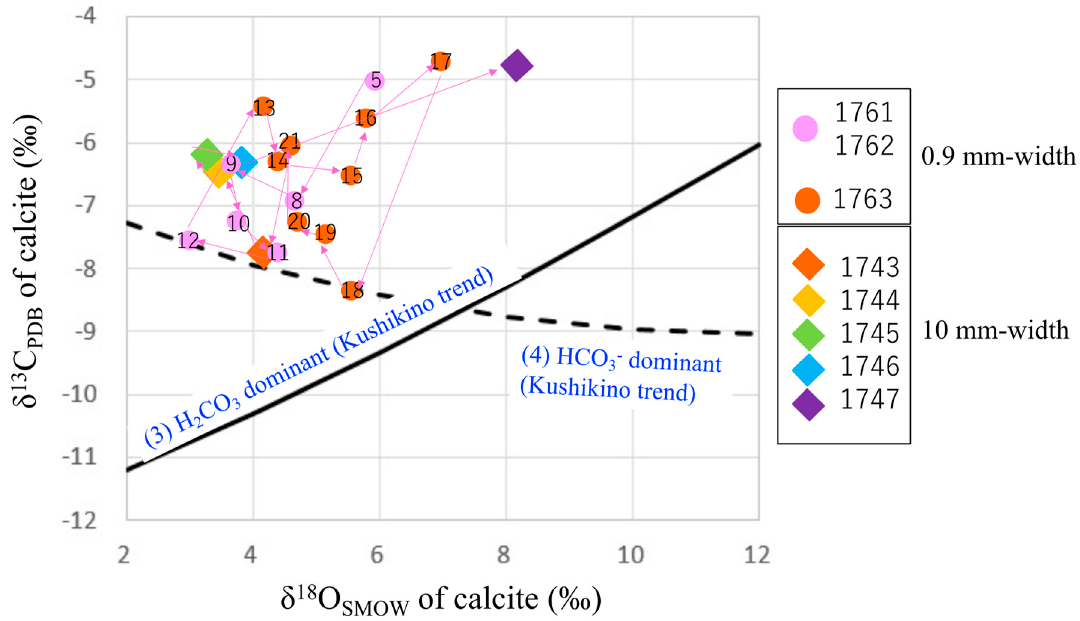
Figure 8. The δ 13 C and δ 18 O values of calcite (10 mm-width sample set and 0.9 mm-width sample set) from the 20100317 sample (Table 3). The number with the symbol represents the growth order in the 0.9 mm-width sample set. The equilibrium fractionation trends of calcite for the Kushikino deposits are shown.